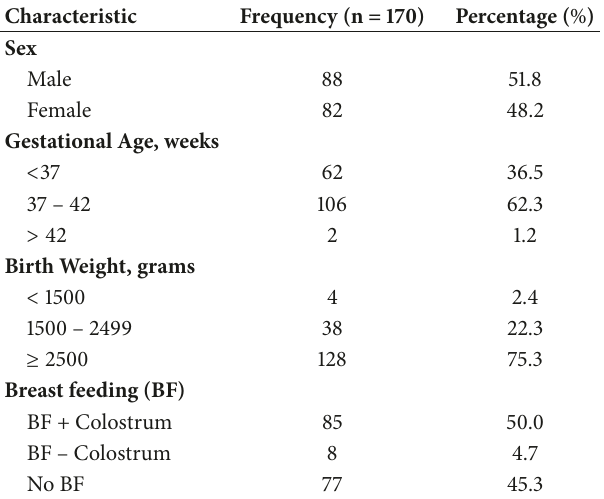
Table 1: Baseline characteristics of the study